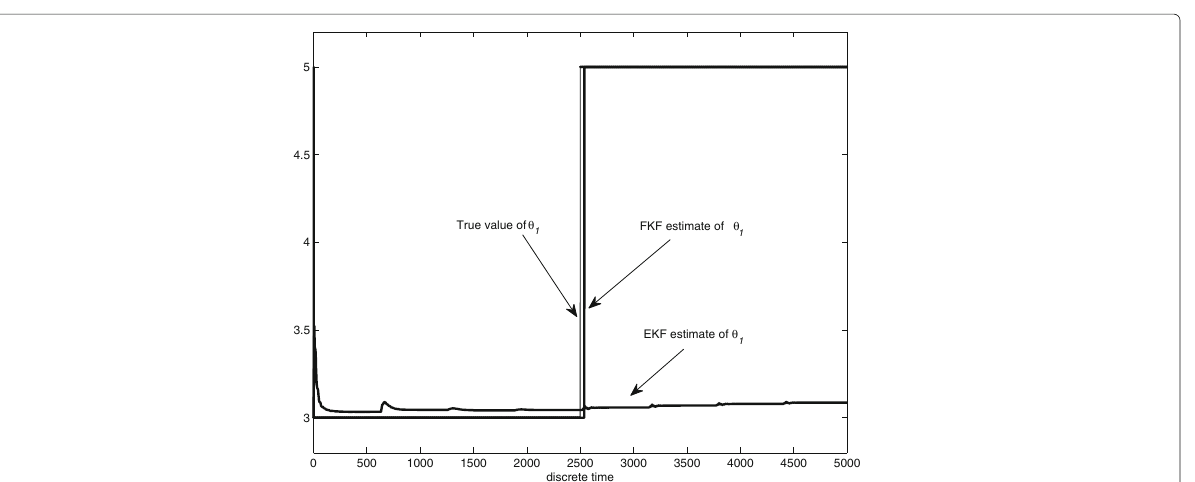
Fig. 8 Estimation of the oscillator’s natural frequency with Extended Kalman Filter (EKF) and Field Kalman Filter (FKF). EKF does not